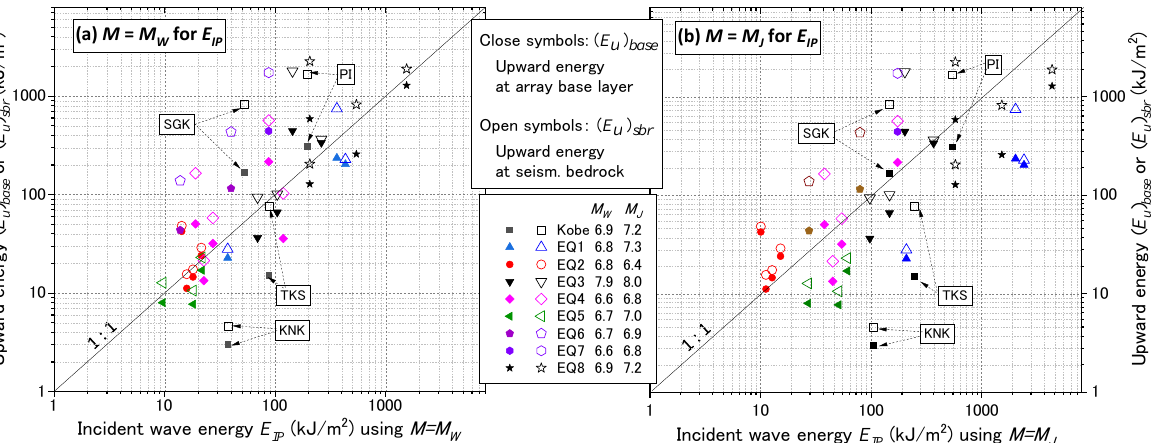
Figure 16. Upward energies ( E u ) base at engineering bedrock and ( E u ) sbr at seismological bedrock versus empirically formulated incident energy E IP by using earthquake magnitude as M = M W ( a ) and M = M J ( b ).